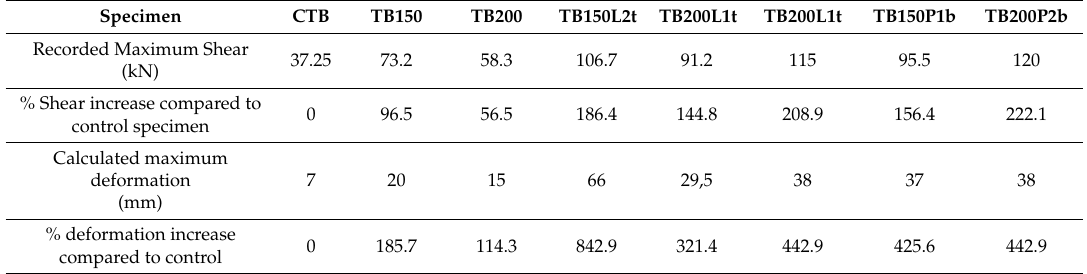
Table 4. Percentage of shear force and deformation increase compared to control specimen.